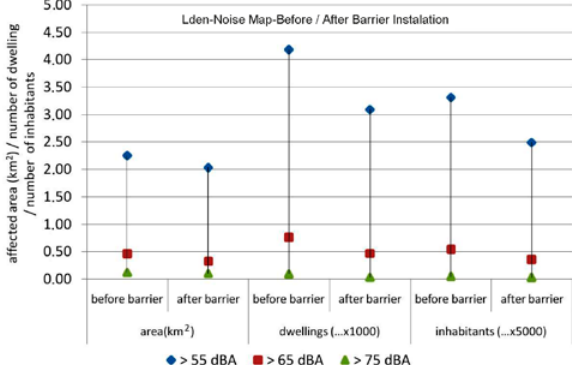
Fig. 9. Changes in figures of affected area-dwellings-habitants in the day-evening-night (L ) time interval with the addition den of noise barriers to the model. (e.g. number of dwellings exposed to noise before barrier over 65 dBA is calculated approx. by 0.8*1000 = 800)